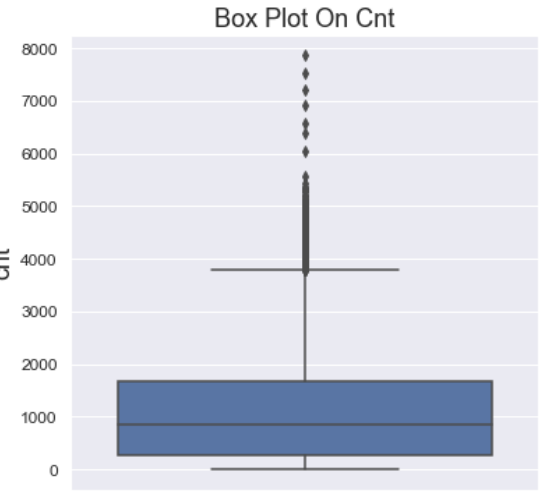
Figure 3. Target variable cnt.